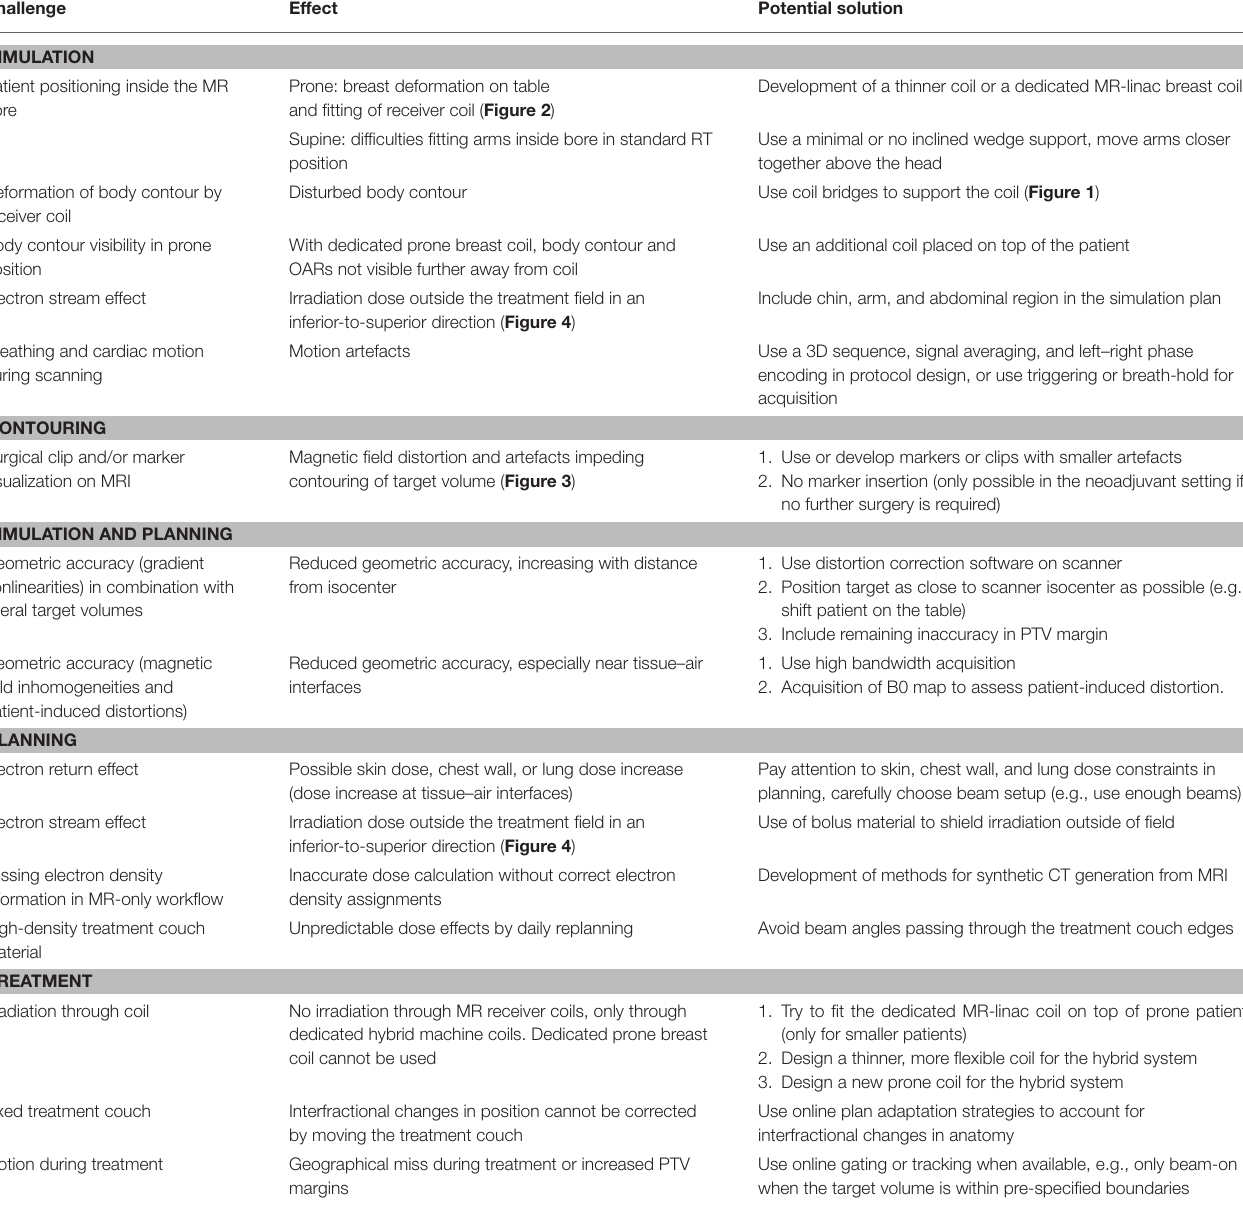
TABLE 1 | Overview of challenges for the implementation of MR-guided radiotherapy on a hybrid machine for breast cancer